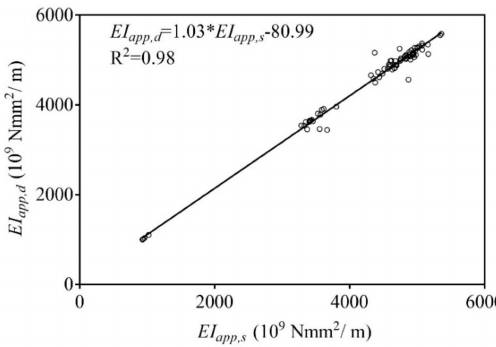
Figure 8. Correlation of apparent bending stiffness measured by modal and static tests.